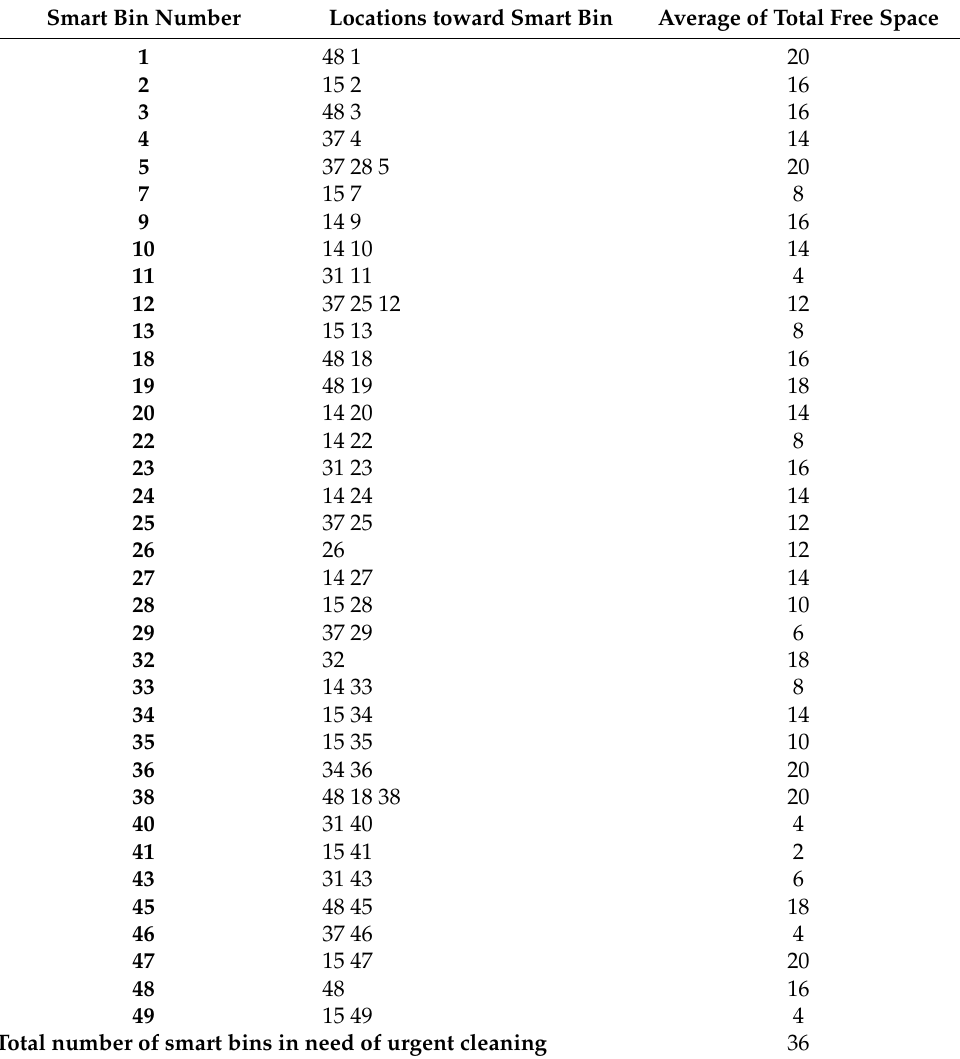
Table 4. Urgent smart bins needed to be cleaned-Type